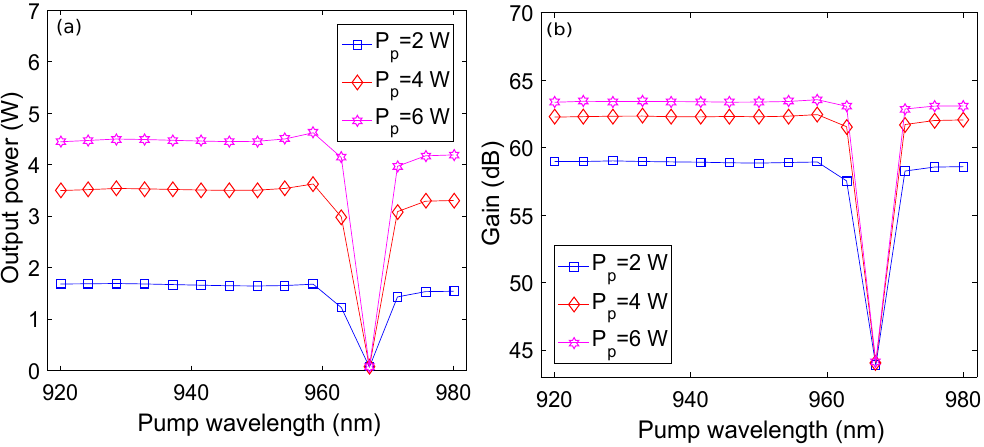
Figure 8. Pump wavelength versus: ( a ) output power plots; ( b ) gain plots. The highest output power obtained from an optical amplifier when a seed of high power, typically around 0 dBm, is given as input to the amplifier is called 3 dB